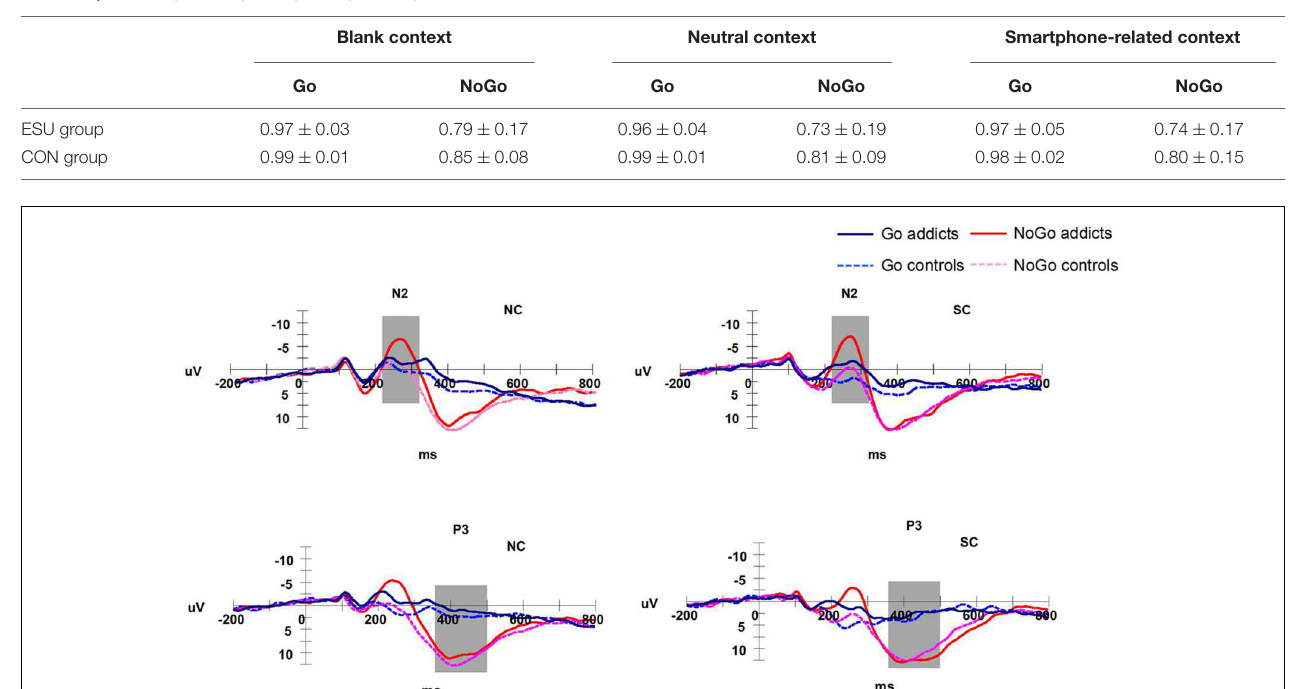
TABLE 2 | Accuracy of the participants (M ± SD).